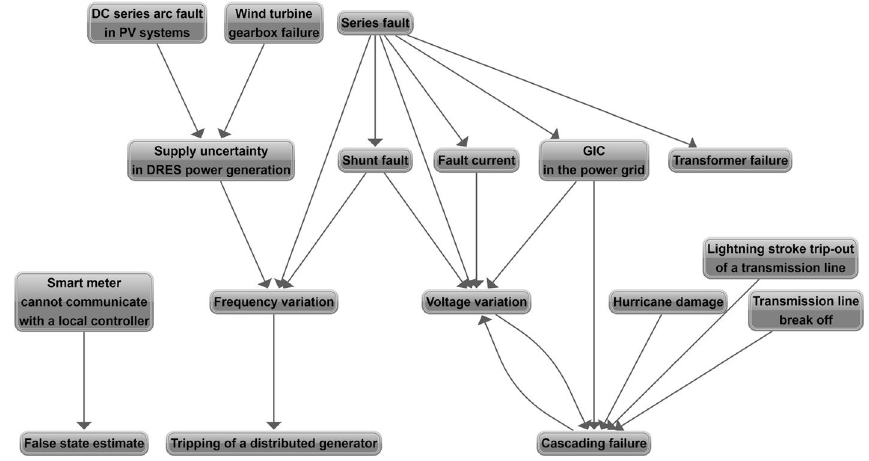
Fig. 5 RQ4. The fault chain